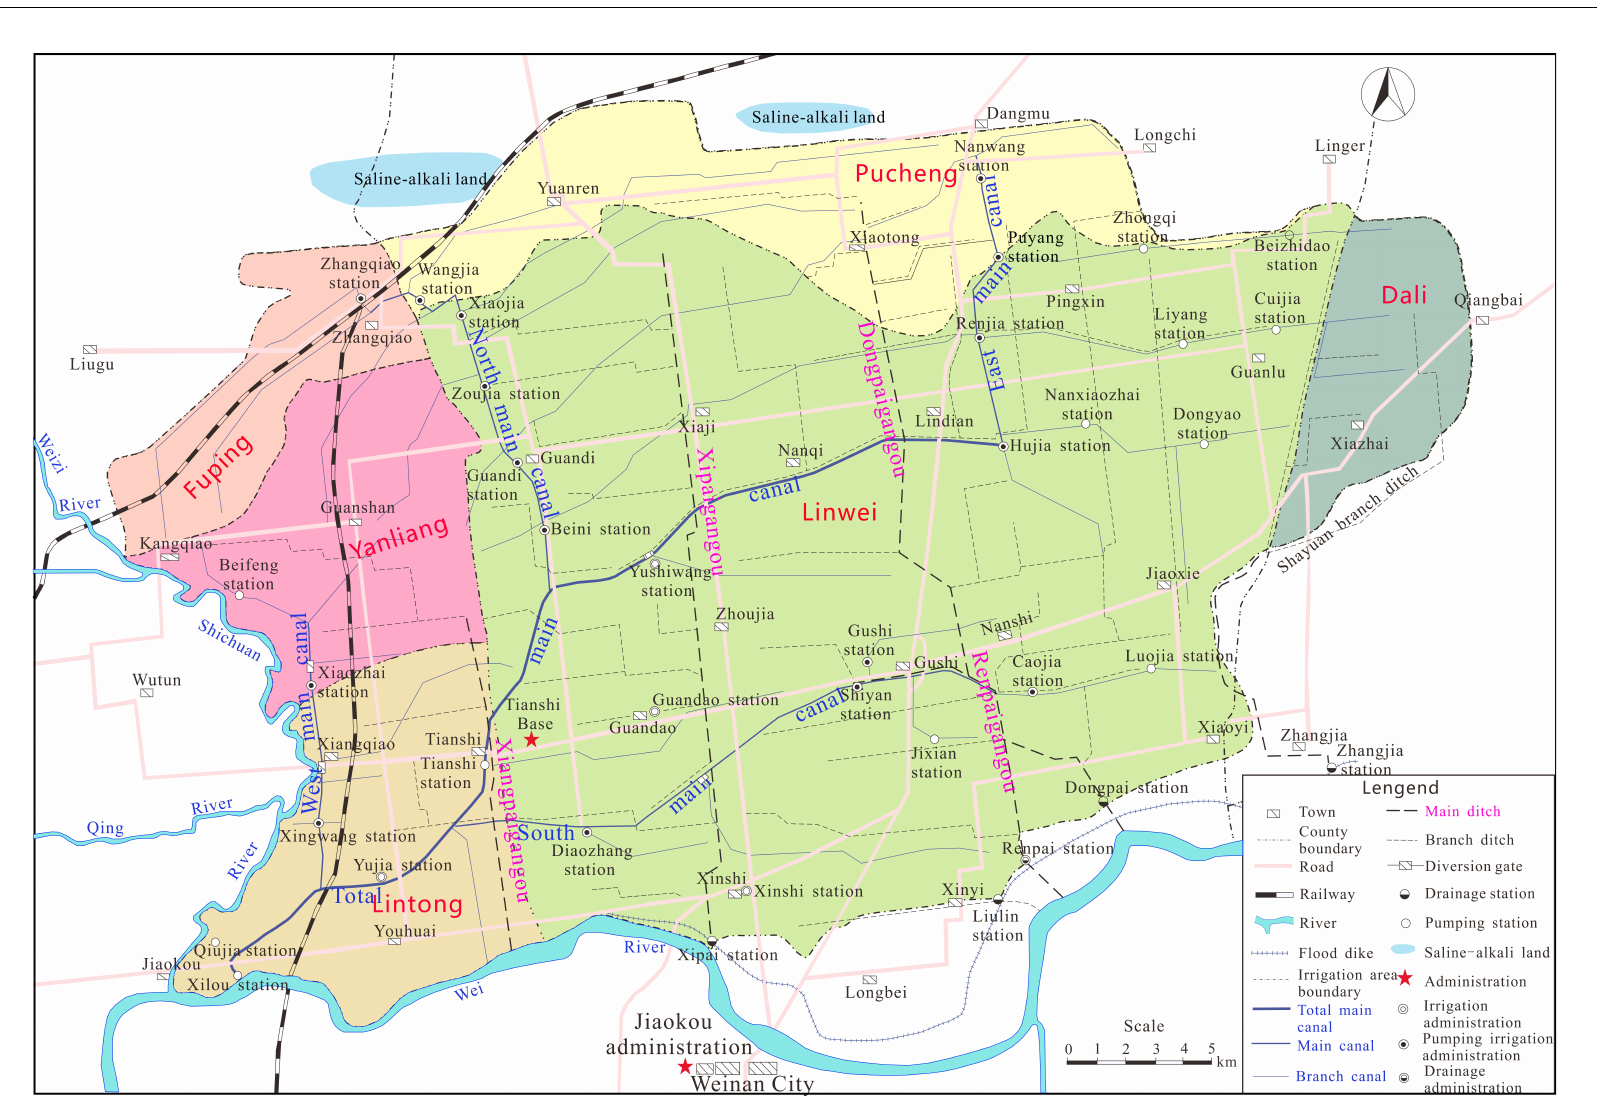
Figure 2. Map of the distribution of canal system and drainage ditches in the Jiaokou Irrigation